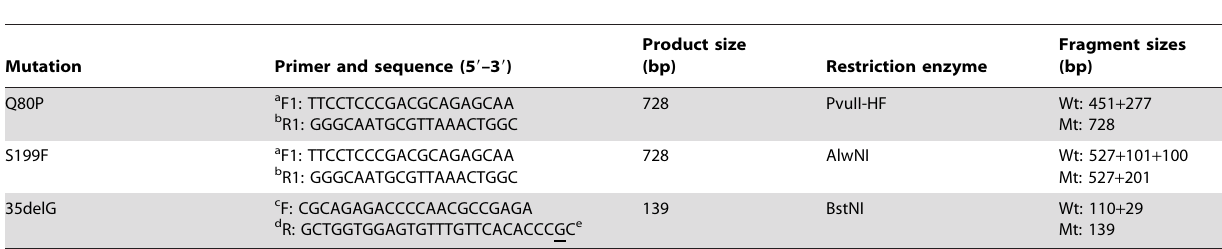
Table 2. PCR-RFLP used to distinguish GJB2 variants Gln80Pro (239A . C), Ser199Phe (596C . T) and 35delG.